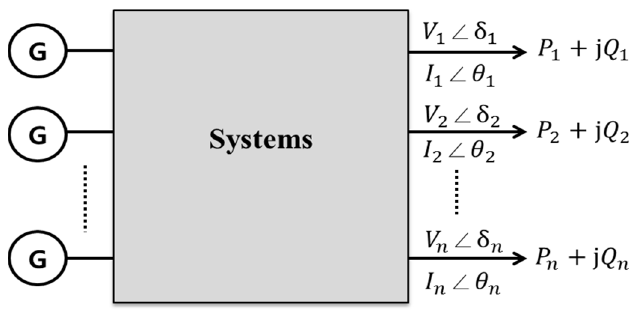
Figure 3. Multiple bus systems with the measurement units.